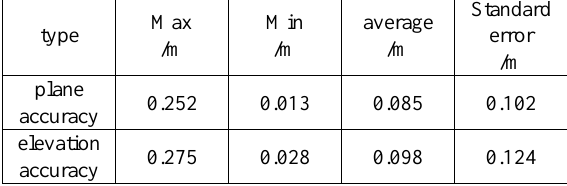
Table 2. Statistics of plane and elevation